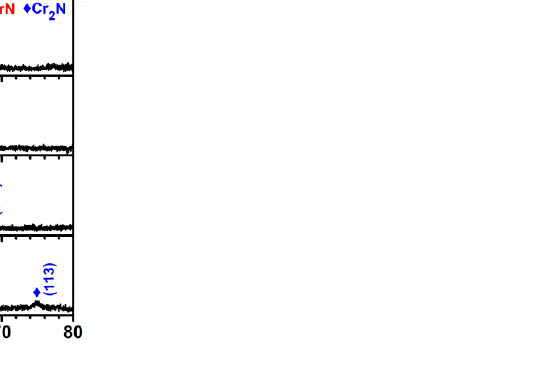
Figure 1. GIXRD patterns of ( a ) Cr 65 W 4 N 31 , ( b ) Cr 62 W 3 N 35 , ( c ) Cr 58 W 2 N 40 , and ( d ) Cr 51 W 2 N 47 coatings.